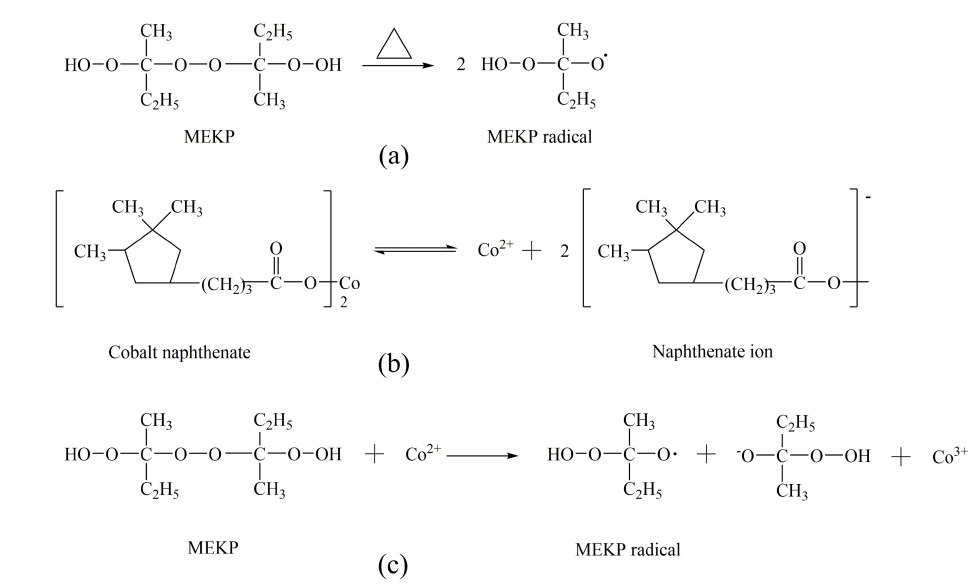
Figure 5. Formation diagram of different radicals: ( a ) free radicals generating without an accelerator; ( b ) the decomposition of cobalt naphthenate; ( c ) free radicals generated under duel synergistic effects of methyl ethyl ketone peroxide (MEKP-II) and cobalt